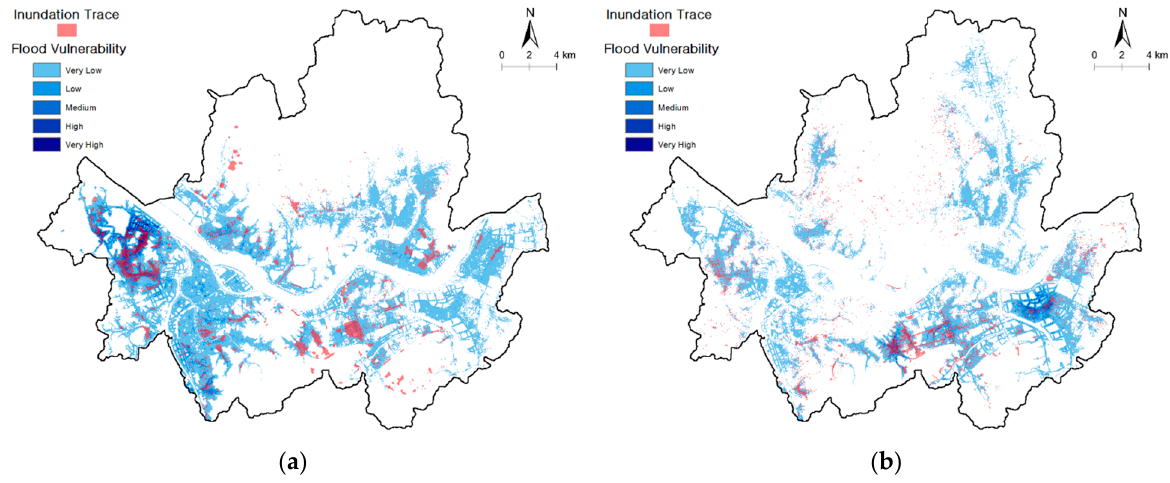
Figure 12. Results of the selection for flood vulnerable areas: ( a ) September 2010; ( b ) July 2011.